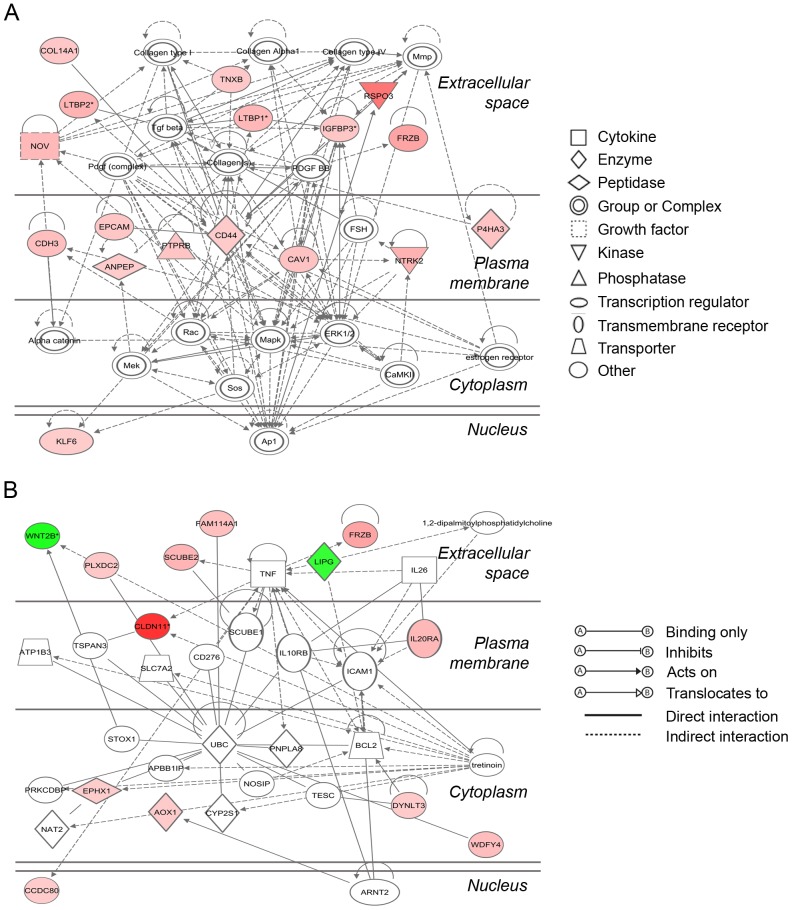
The two most significant gene networks mapped in IPA.The networks were generated in IPA using triangle connectivity based on focus genes (those present in our data set) and built up according to the number of interactions between a single prospective gene and others in the existing network, and the number of interactions the prospective genes have outside this network with other genes as determined by IPA [65]. Network A (score = 39), shows interactions between LTBP1, LTBP2, COL14A1 and TNXBI indicating extracellular matrix signalling and network B (score = 28), shows involvement of Wnt pathway members WNT2B and FRZB. Interactions between molecules, and the degree and direction of regulation are indicated with up- (red) or down-regulation (green) and increasing color intensity with degree of fold change.